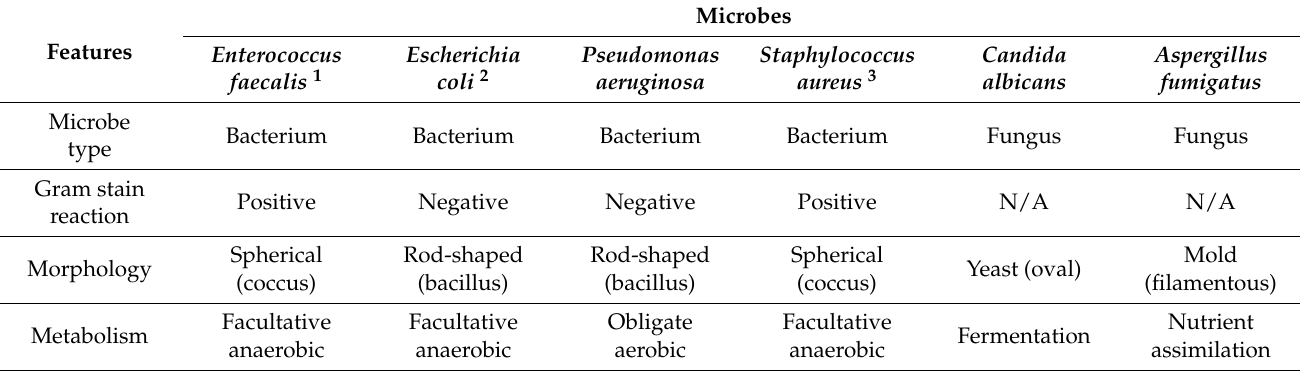
Table 1. Characteristics of Tested Bacteria and Fungi (n =